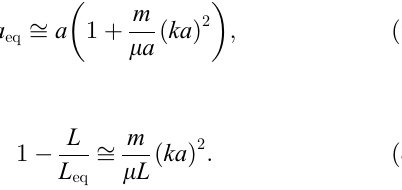
¼ 1 (cid:2) f n ¼ (cid:2) I n are nf 0 L eq Leq L log2